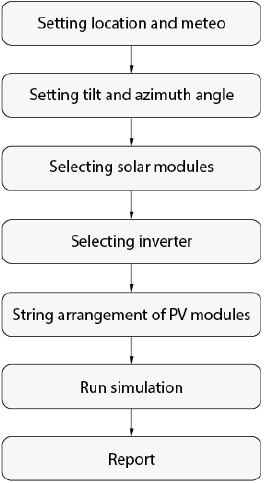
Figure 6. Simulation process by PVsyst software